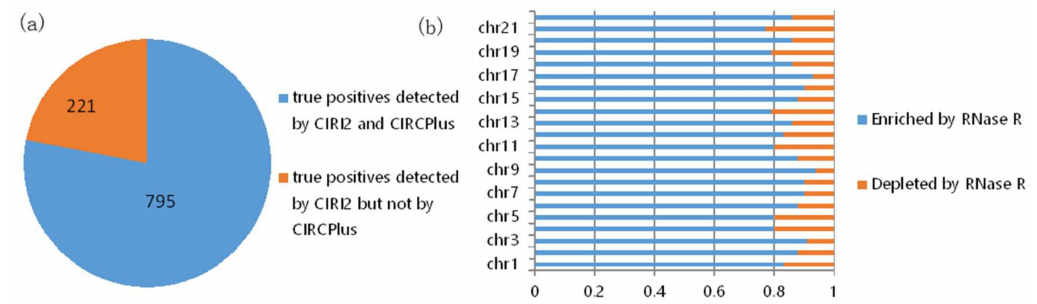
Figure 3. ( a ) Overlap of circRNAs predicted by CIRCPlus and CIRI2 on the HEK293 datasets. ( b ) RNase R resistance of each chromosome predictions only detected by